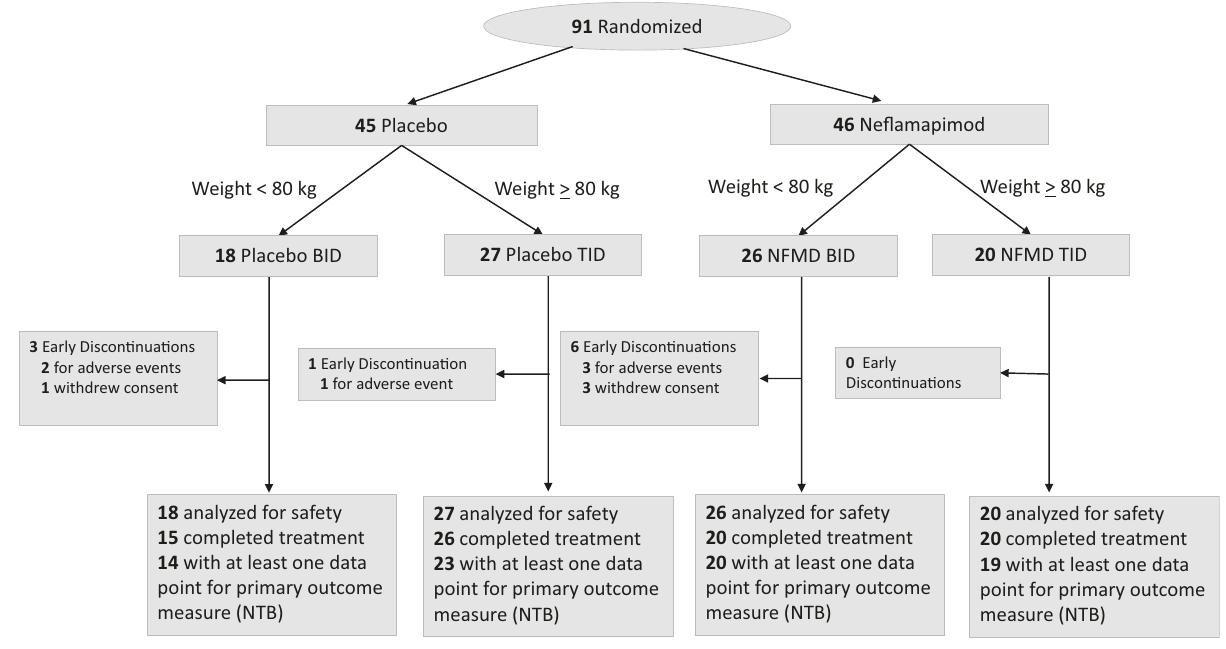
Fig. 4 | CONSORT fl ow diagram for the AscenD-LB Phase 2a clinical trial. CONSORT 2010 Statement fl ow diagram showing participant fl ow through each